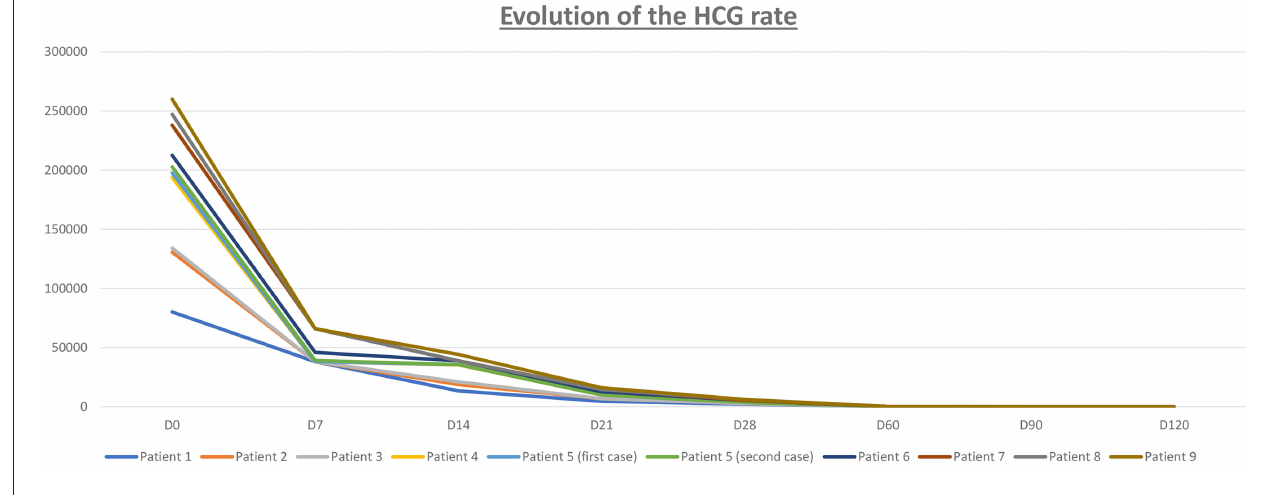
FIGURE 3 | Evolution of the HCG rate (Human Chorionic